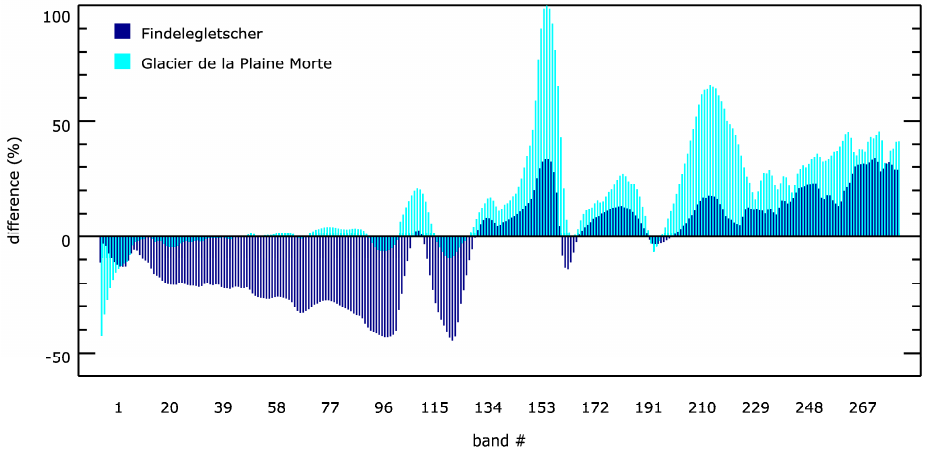
Figure A3. Average difference in percent before and after calibration of APEX scenes per individual band.